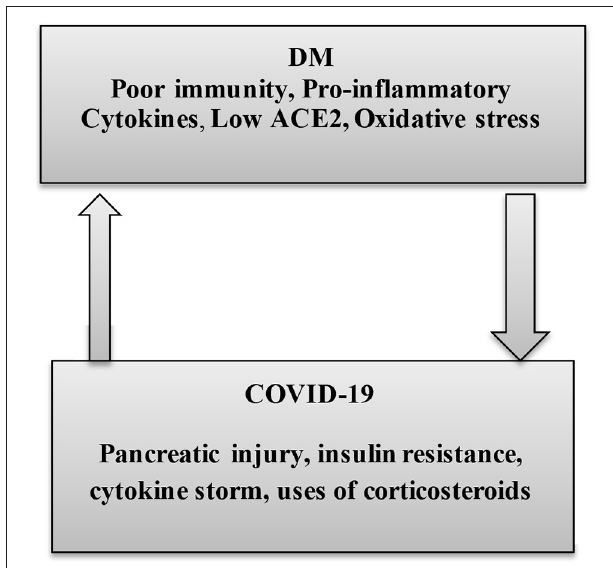
FIGURE 4 | The interaction between diabetes mellitus and COVID-19. In diabetes mellitus (DM), poor immunity, high pro-inflammatory cytokine, low ACE2, and oxidative stress increase susceptibility for COVID-19. Below, COVID-19-induced pancreatic injury, insulin resistance (IR), cytokine storm, and uses of corticosteroids in the management of COVID-19 collectively participate in the induction of